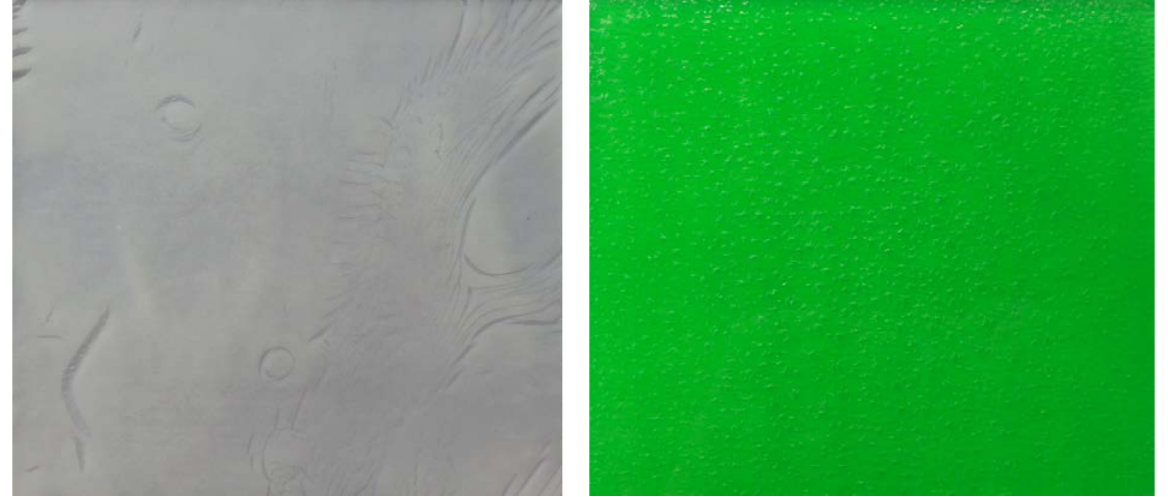
Fig. 17 Sample with the film 2 and paint sprayed between two films Fig. 18 Sample with film 4 and brushed paint between two